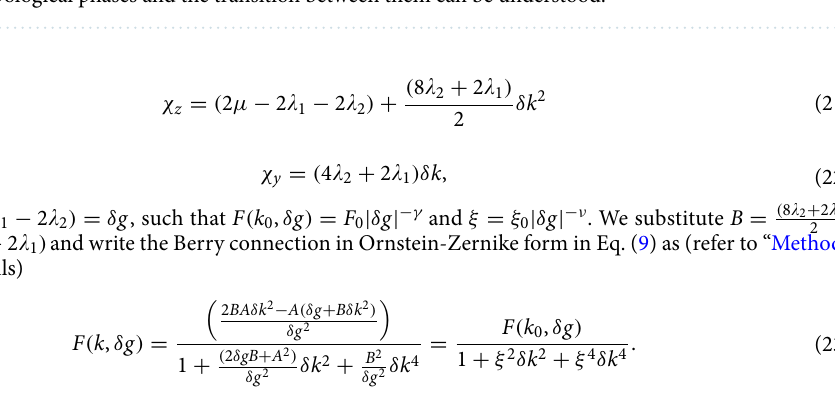
0 in (cid:31) 1 - (cid:31) 2 plane for ( a ) µ 0.5 and ( b ) µ 1 . The RG flow directions are Figure 6. Flow diagram for k 0 = = = pointed by the arrows. The critical lines are shown as solid lines and fixed lines as dashed lines. Analyzing RG flow, distinct topological phases and the transition between them can be